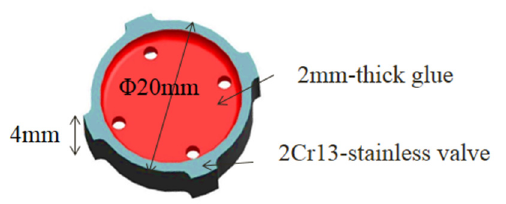
Figure 1. Schematic diagram of 2Cr13 stainless